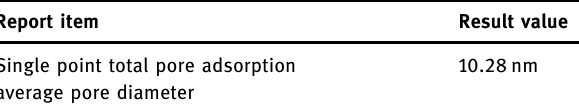
Figure 3: E ff ect of pH on the adsorption of Cu 2 + , Pb 2 + , and Cd 2 + by